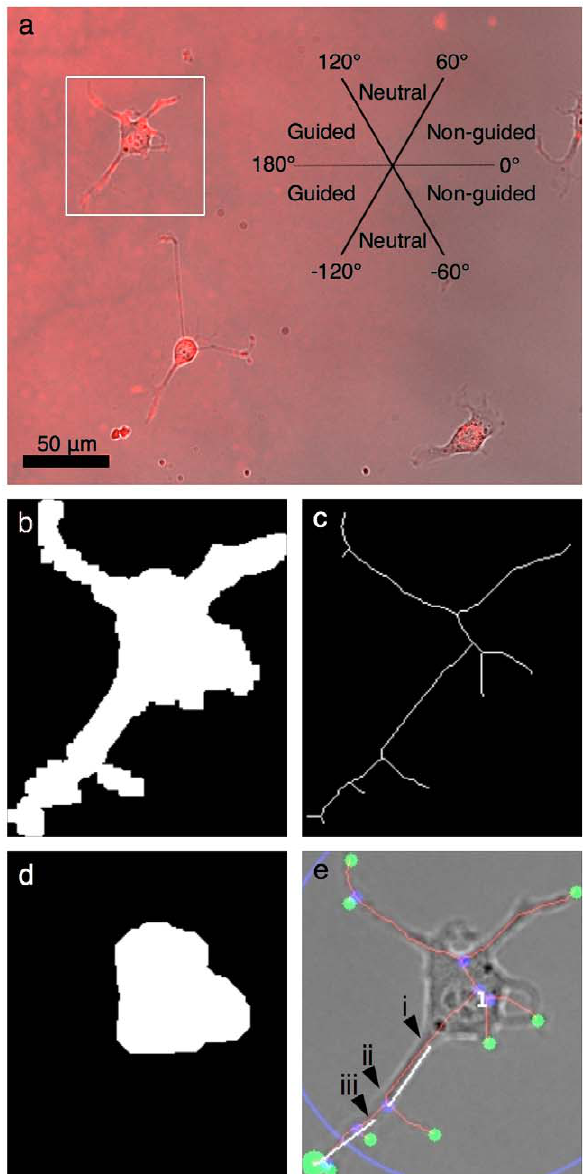
Figure 2. Image analysis algorithm key steps. RGC-5 cells on a low- slope laminin-1 gradient where a streptavidin-Cy5 gradient was imaged by fluorescence microscopy with cells in bright field mode using a 20 6 0.75 NA objective. (a) The properties of the longest neurite of each